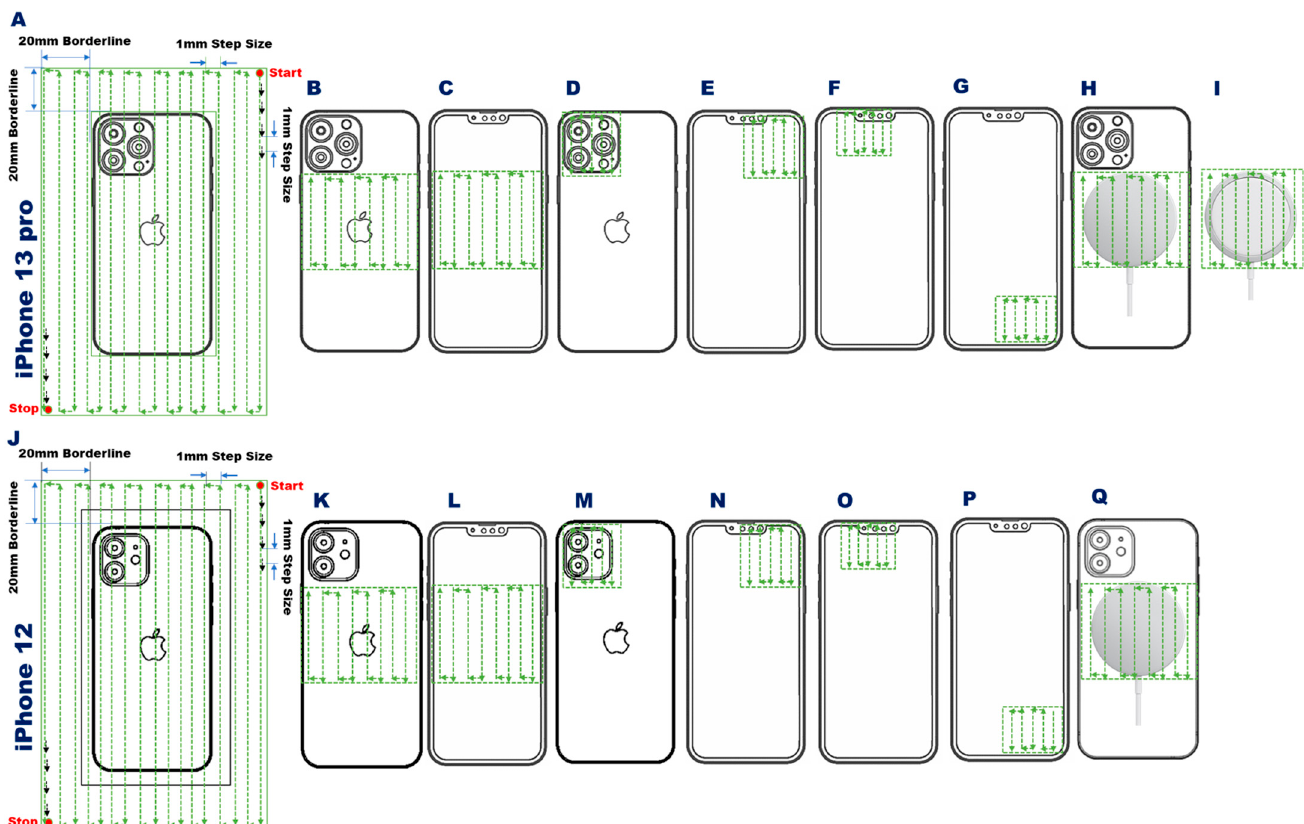
Figure 2. Sampling trajectory of the Hall probe used for magnetic field mapping of the iPhone 13 Pro, the iPhone 12, and the MagSafe wireless charger with a 1 mm in-plane spatial resolution. Yellow dashed lines represent the trajectory of the Hall probe using a 1 mm step size. A , J : Sampling trajectory used for full coverage of the iPhone 13 Pro ( A ) and iPhone 12 ( J ) with a field of view FoV = 100 × 180 mm. B , C , K , and L : Sampling trajectory tailored to the annular array of magnets of the iPhone 13 Pro ( B : back, C : front) and of the iPhone 12 ( K : back, L : front) using an FoV = 62 × 62 mm. D , E , M , and N : Sampling trajectory used for B-field mapping of the camera of the iPhone 13 Pro ( D : back, E : front) and of the iPhone 12 ( M : back, N : front) using an FoV = 40 × 40 mm. F , G , O , and P : Sampling trajectory used for B-field mapping of the speakers of the iPhone 13 Pro ( F : top, G : bottom) and of the iPhone 12 ( O : top, P : bottom) using an FoV = 30 × 30 mm. H , I , and Q : Sampling trajectory used for B-field mapping of the iPhone 13 Pro placed on the MagSafe charger ( H ), the iPhone 12 placed on the MagSafe charger ( Q ), and of the standalone MagSafe charger ( I ) using an FoV = 62 × 62 mm.